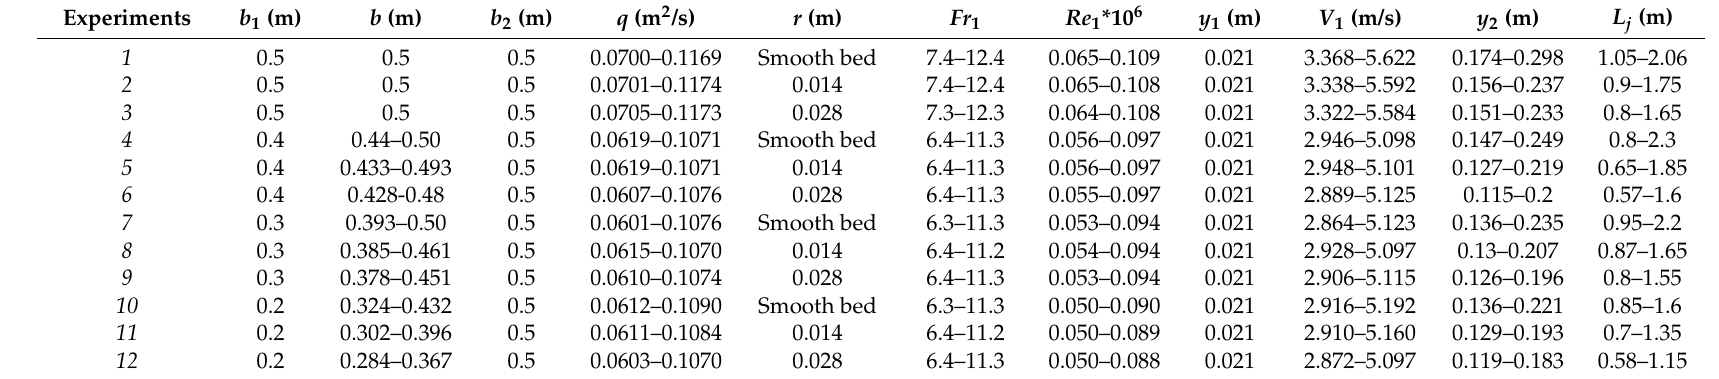
Table 2. Main characteristics of the experiments carried out in the present